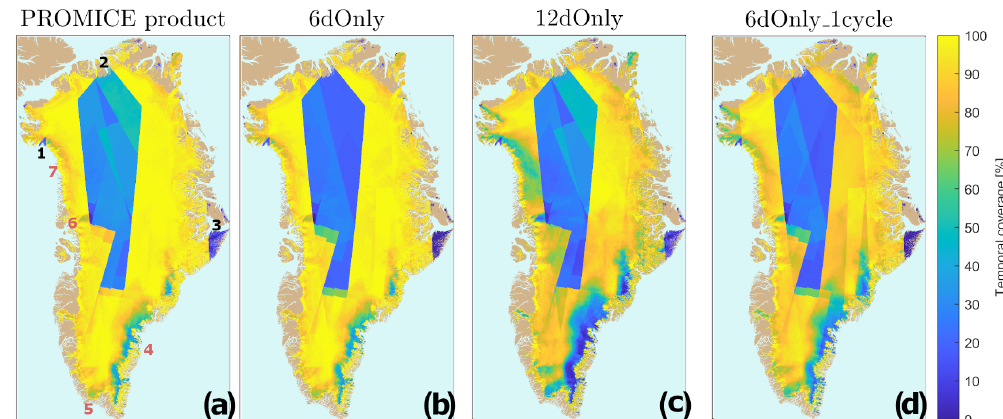
Figure 11. Temporal coverage: spatial view of the percentage of all mosaics that have data in a given grid point: (a) the PROMICE Ice Velocity product, (b) 6dOnly time series, (c) 12dOnly time series, and (d) 6dOnly_1cycle time series. The numbers in panel (a) indicate the locations of the areas mentioned in Sect. 6. Areas where SAR in IW mode has not been acquired on a regular basis: 1, 2, and 3 refer to the triangular area in Melville Bay, north Greenland, and the Scoresbysund area, respectively. Areas with low ice velocity coverage: 4, 5, 6, and 7 refer to the southeast ice sheet margin, small area in south Greenland, an area north of Rink Glacier, and the Melville Bay area,